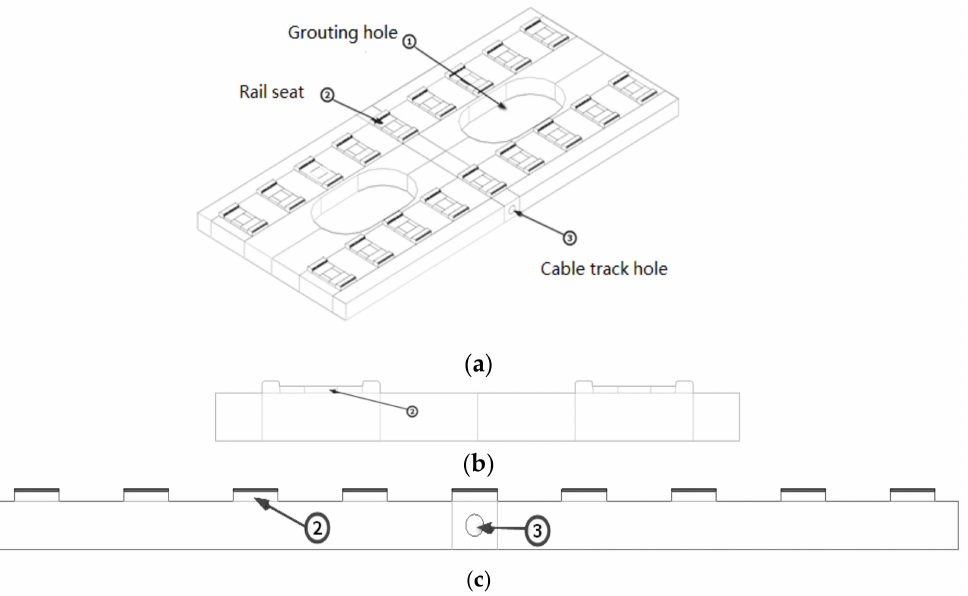
Figure 3. Schematic diagram of NFTBT’s structure: ( a ) the whole frame; ( b ) schematic diagram of the main view; ( c ) schematic diagram of the side